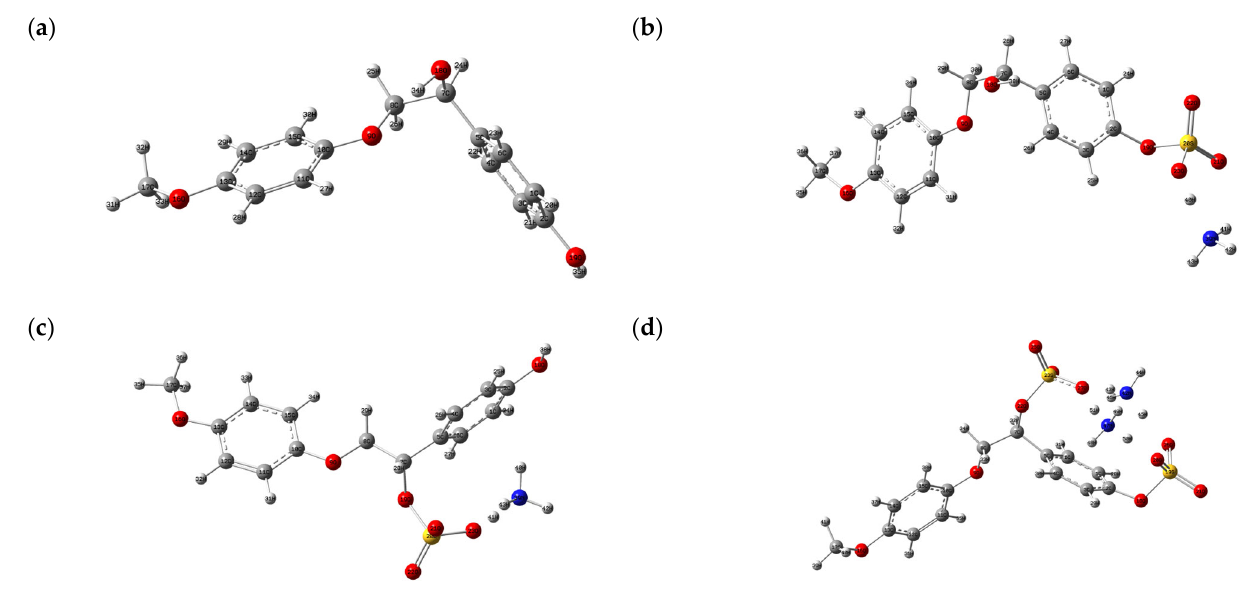
Figure 8. Optimized molecular structure: initial β -O-4 lignin ( a ), and sulfated β -O-4 lignin with the sulfate group localized at the aromatic ( b ), alkyl ( c ), and alkyl and aromatic ( d ) hydroxo groups.